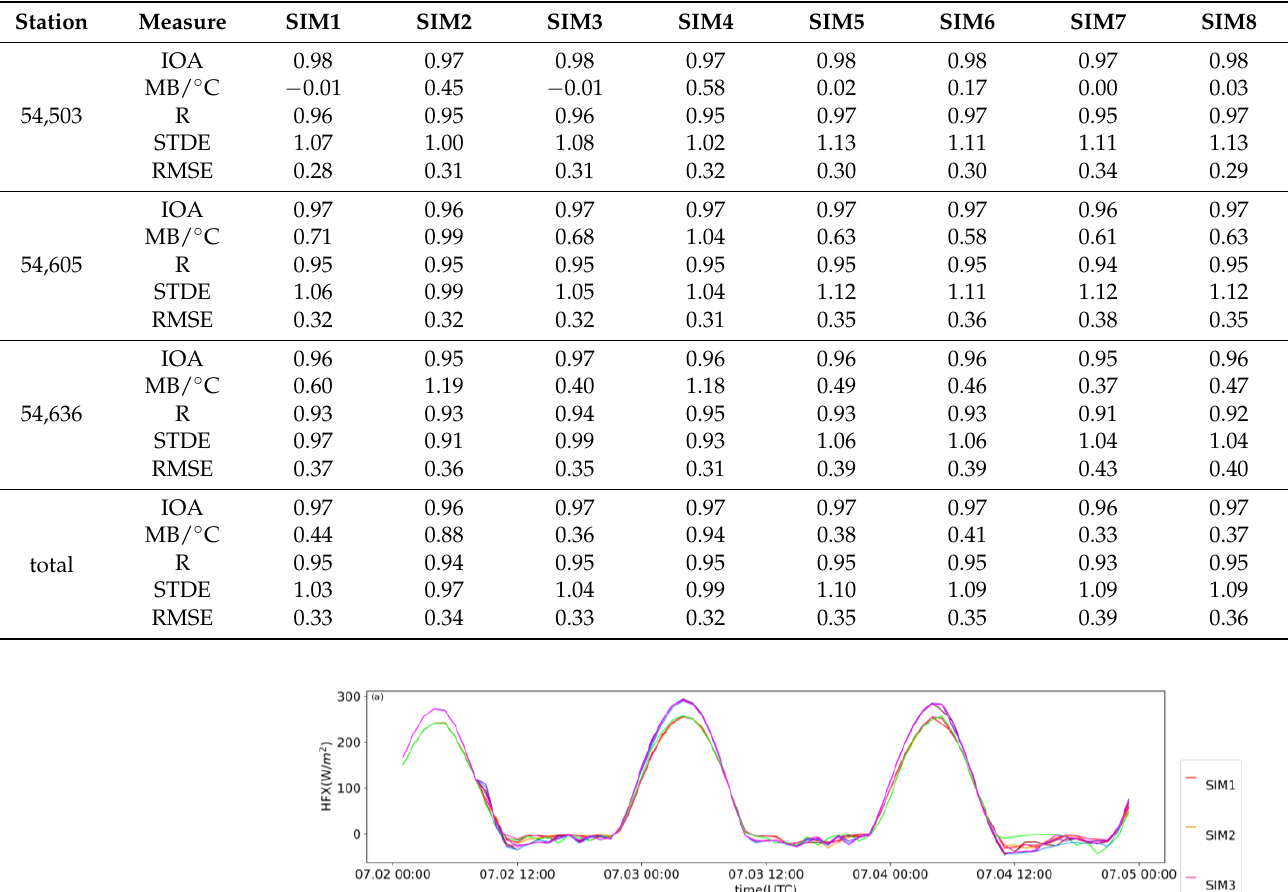
Table 2. The 2-m temperature in the Xiongan New Area from observations and eight combined scheme simulations.